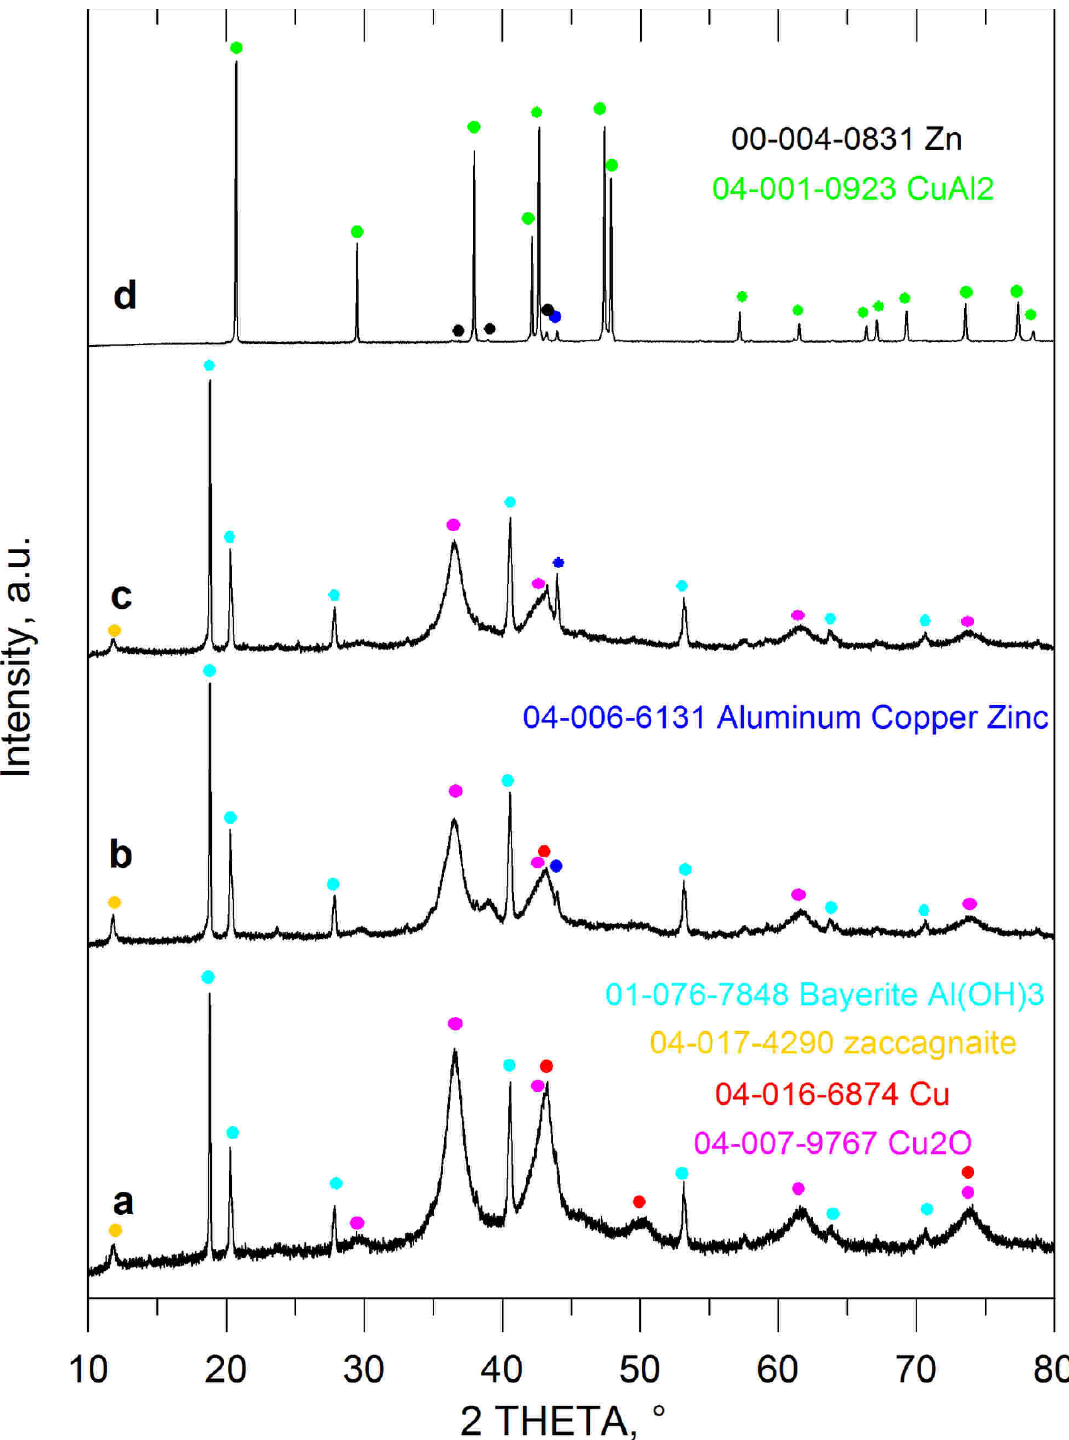
Figure 4. The comparison of powder X-ray diffractograms of Dev. alloy ( d ) unused; ( c ) used for overnight HDB of 5 mM BRX in aq. 100 mM NaOH; ( b ) recycled from step c and subsequently used for overnight HDB of 5 mM BRX in aq. 100 mM NaOH and coaction of NaBH 4 ; ( a ) recycled from step b and used for overnight reaction with 5 mM BRX dissolved in 100 mM NaOH and coaction of NaBH 4 .